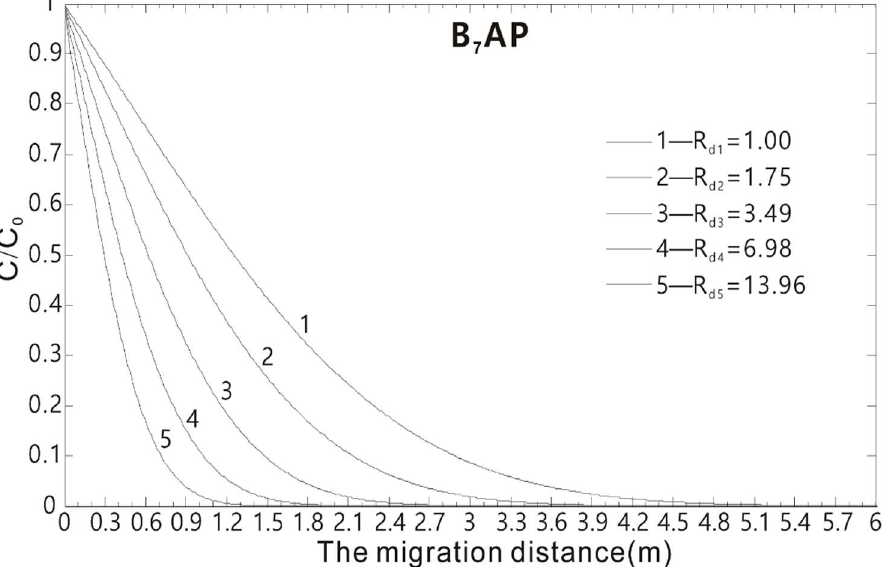
Figure 10. Effect of retardation factor on migration of uranium in B 7 AP buffer material (t = 10,000